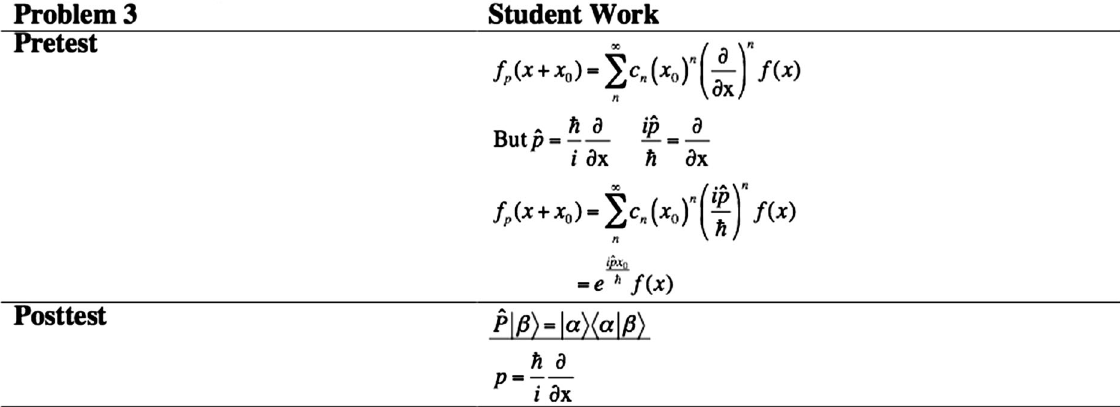
FIG. 5. An example of a pretest and posttest solution pair for a student from the comparison group which demonstrates a typical deterioration for the momentum problem. The pretest and posttest scores are 89% and 0% for invoking, 100% and 0% for applying, and 95% and 0% for the overall scores, respectively. The pretest solution is nearly perfect, but in the posttest, no relevant knowledge is